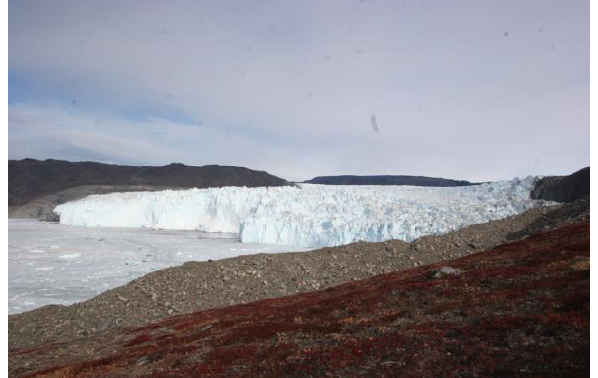
Figure 11. Egi glacier face, (Pavelka, 2015)